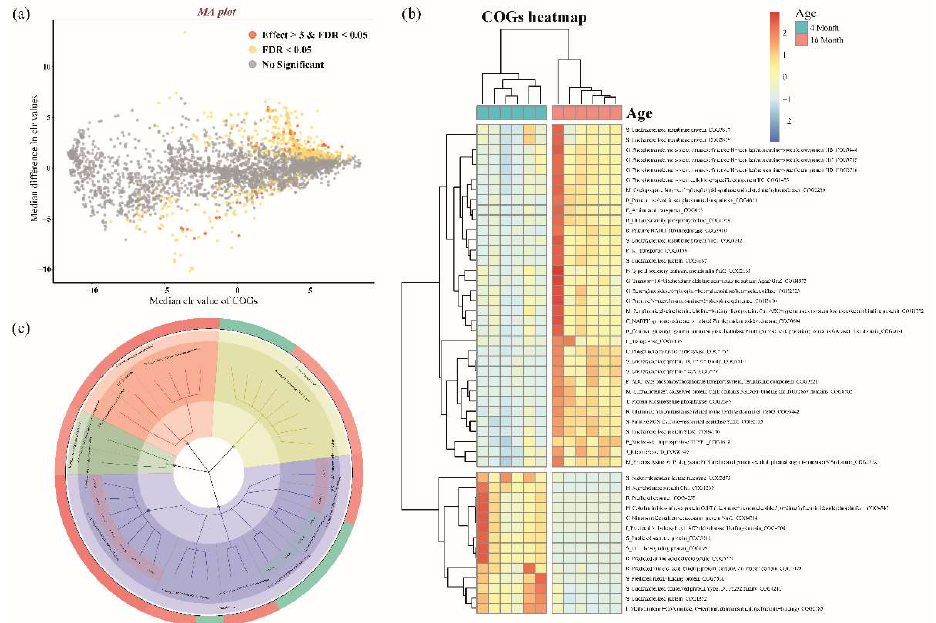
Figure 3. ( a ) Significantly distinct COGs determined by ALDEx2 algorithm between the 4 and 16-month-old group using the MA plot (BH adjusted p -value < 0.05 and effect size > 3 (distinct in 4 months) or effect size < −3 (distinct in 16 months)). Only the significantly distinct COGs are catego- rized by the function of COGs. ( b ) The heatmap presents the predicted functions based on signifi- cantly distinct COGs in the 4-month-old and 16-month-old groups. The heatmap colors indicate the normalized relative abundance of COGs numbers based on the KEGG pathway using the PICRUSt2. ( c ) Circular dendrogram of COGs of the 4-month-old and 16-month-old groups present the outliers, respectively, indicated in green and red. The second inner side, the second position from the most outside, showed COG classes indicating the “Cellular process and signaling” (red), “Information storage and processing” (emerald green), “Metabolism” (blue), and the “Poorly characterized” (yel- low). The next inner side showed the COGs functional categories. “Metabolism” of COGs classes, “G, Carbohydrate transport and metabolism”, “E, amino acid transport and metabolism”, and “F, Nucleotide transport and metabolism” categories are shown in the 16-month-old group, and the “H, Coenzyme transport and metabolism” and “I, Lipid transport and metabolism” are shown in the 4-month-old group. 4. Discussion This study aimed to determine changes in the fecal microbiome of Jindo dogs over time during different growth stages. Further, we attempted to eliminate the variations of dietary effects due to the intestinal microbiome by subjecting the Jindo dogs to the same feed throughout the experiment. In this study, we compared 4- and 16-month-old Jindo dogs representing puppies and adults; however, we did not analyze other age groups and suggest only information about the fecal microbiomes between these two age groups. Prior studies identified the fecal microbiota composition according to the growth stage of dogs [17,29,30]. Firmicutes , Fusobacteria , Bacteroides , Proteobacteria , and Actinobac- teria were common at the phylum level, whereas Lactobacillus , Fusobacterium , Prevotella , and Bacteroides were common at the genus level. These results were identical to those of our study, except for the dog environment and age, and it was determined that the dom- inant genera were consistent between the studies. Following this, changes in microbial species richness were investigated, but there were no significant results (Figure 1c). How- ever, contrary to our findings, other studies using a similar experimental design showed changes in microbial species diversity. A significant difference was found in microbiome abundance and diversity between dogs before and after weaning and among puppies, adult dogs, and old dogs [17,31,32]. However, it has been observed that in humans, the